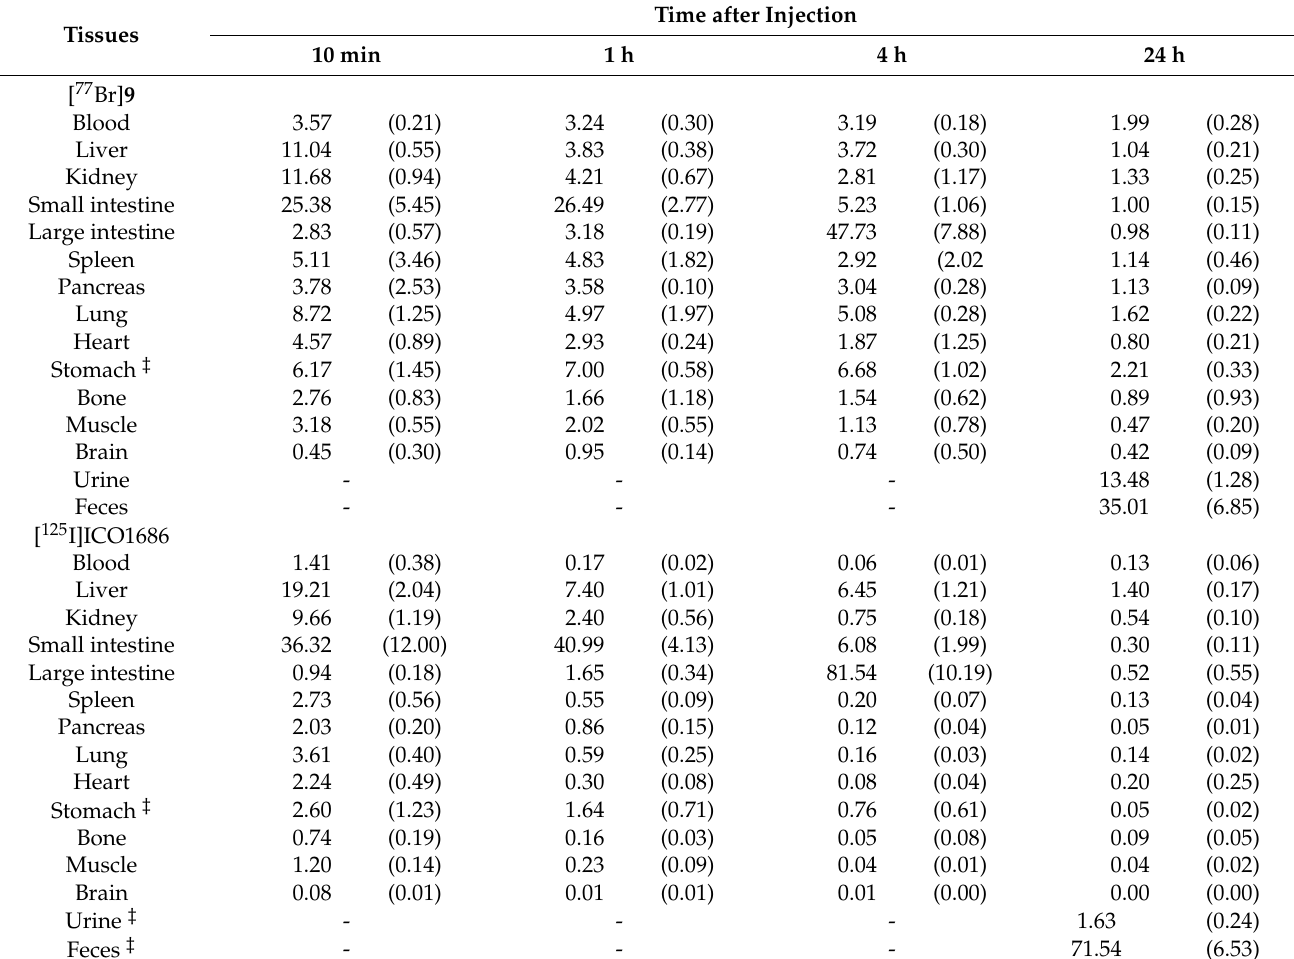
Table 2. Biodistribution of [ 77 Br] 9 and [ 125 I]ICO1686 at 10 min, 1, 4, and 24 h after i.v. injection in ddY mice.